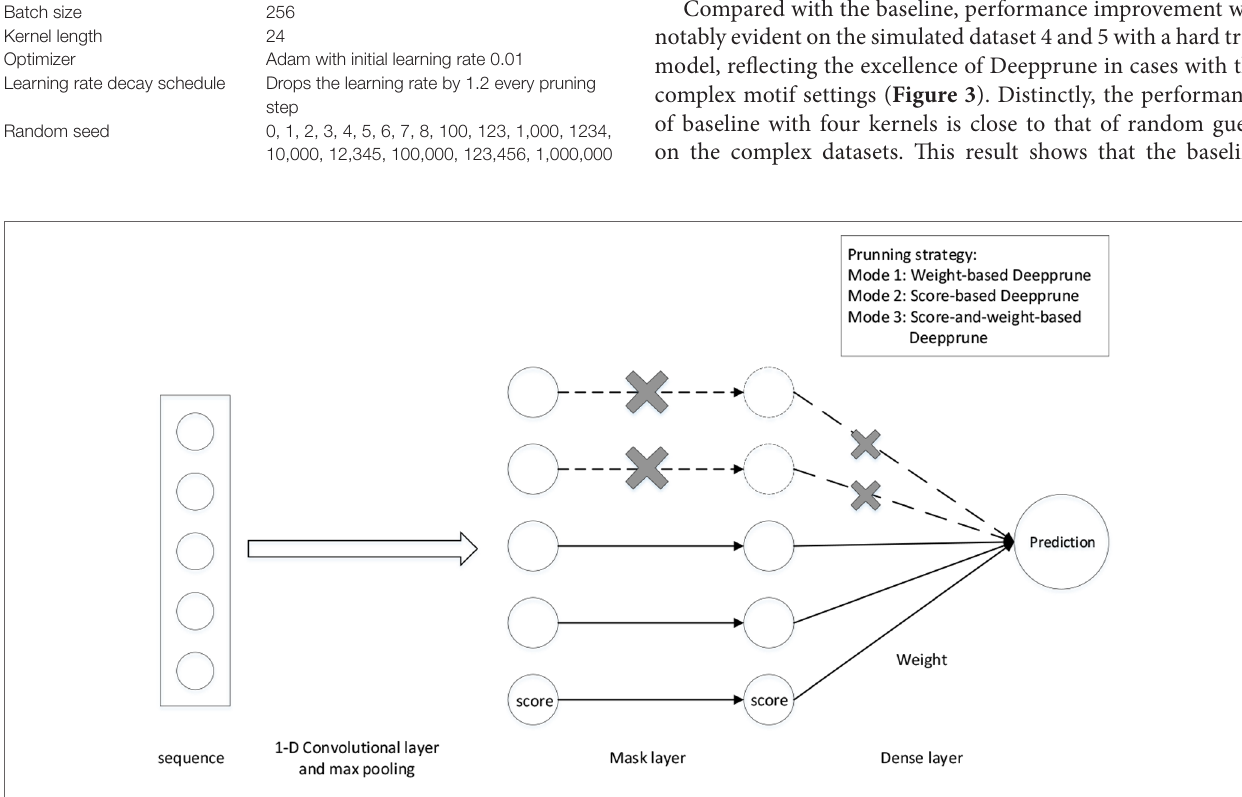
Frontiers in Genetics |